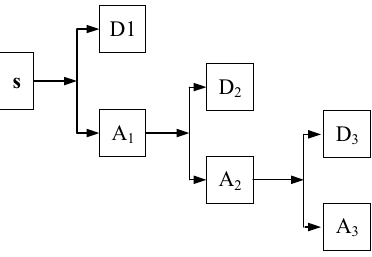
Figure 1. Three-level hierarchy chart of the DWT.